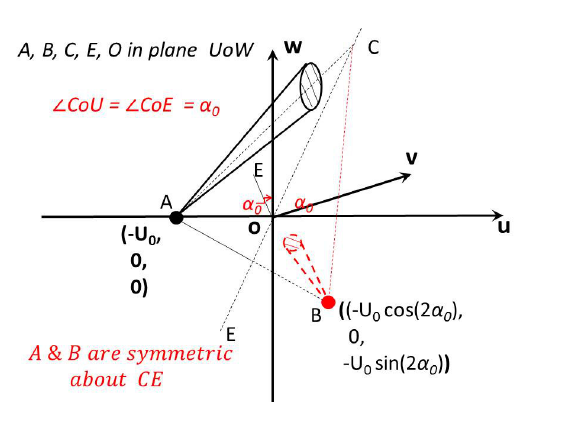
Figure 13. Illustration of the problem of a round jet impinging on a specular reflective plate. Dashed lines: virtual nozzle.